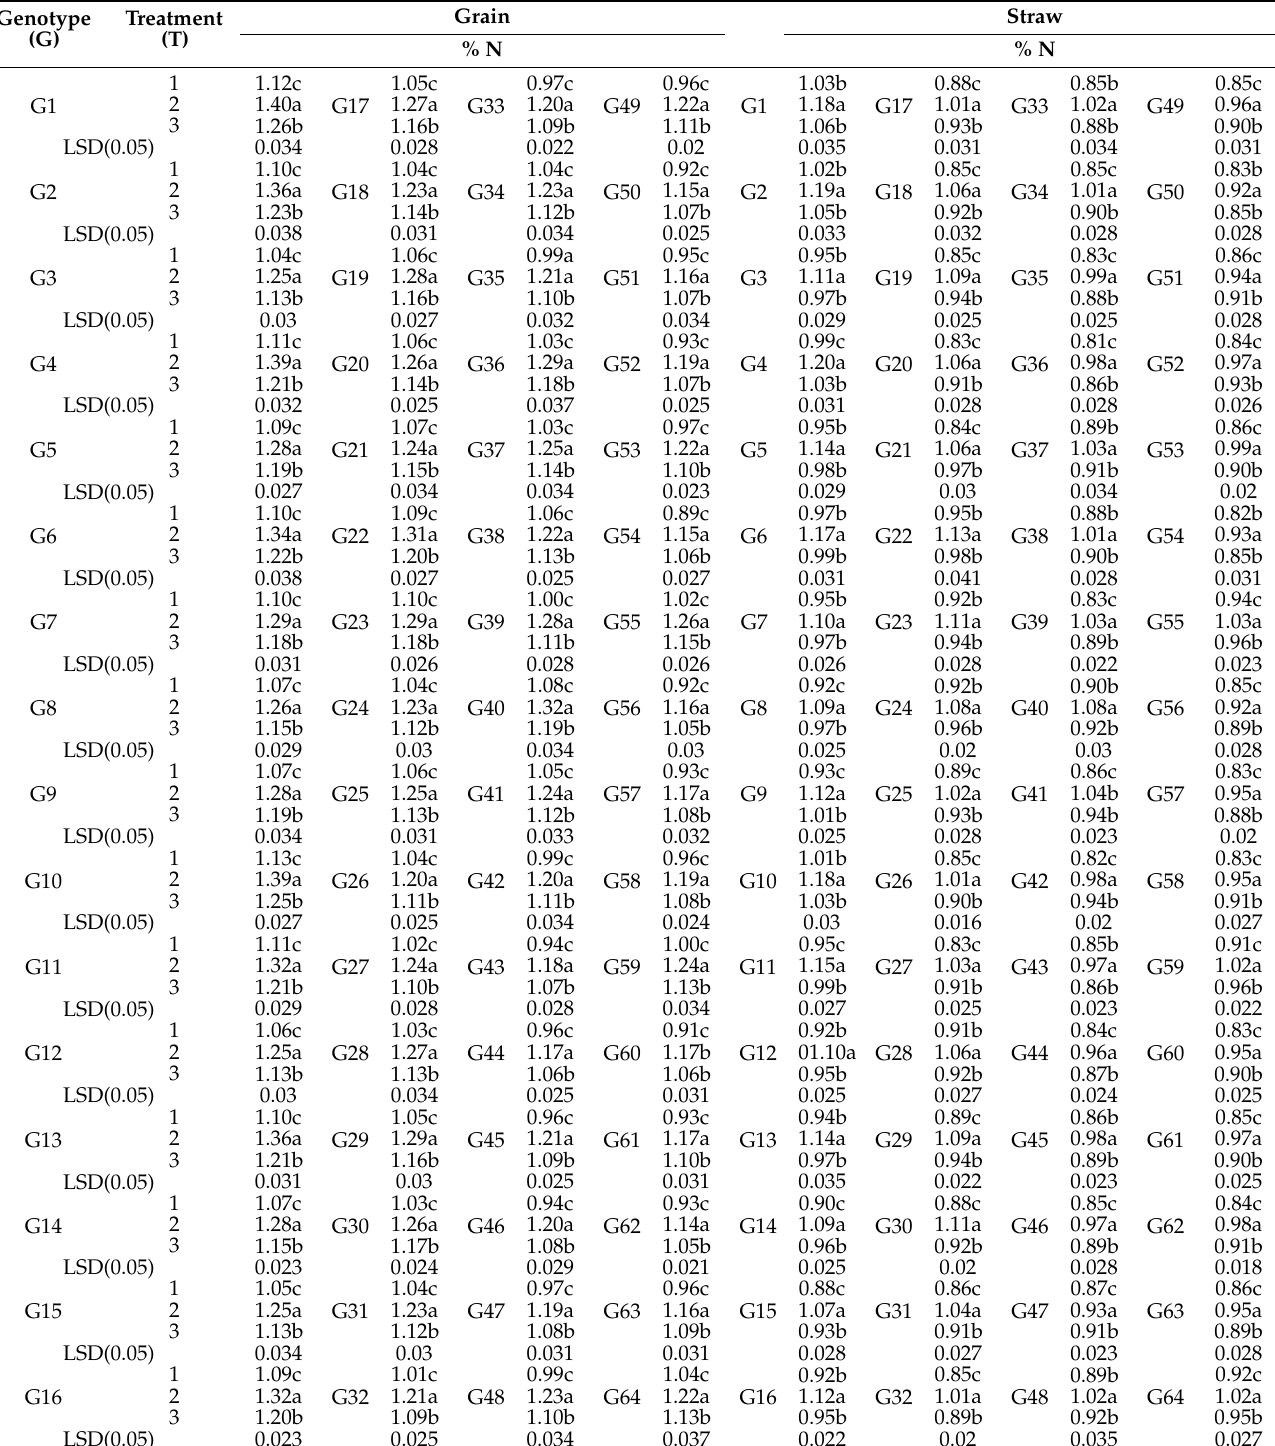
Table 10. Grain and straw nutrient content (% N) of 64 rice genotypes as influenced by treatment and genotype (pooled over two